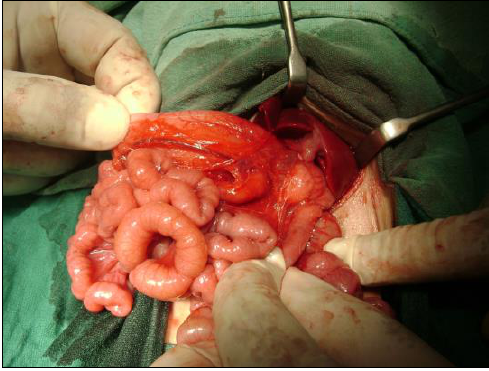
Figure 2: Case 2- PDPV crossing anteriorly to duodenum. Heterotaxy can be appreciated (stomach right sides and gallbladder left sided).